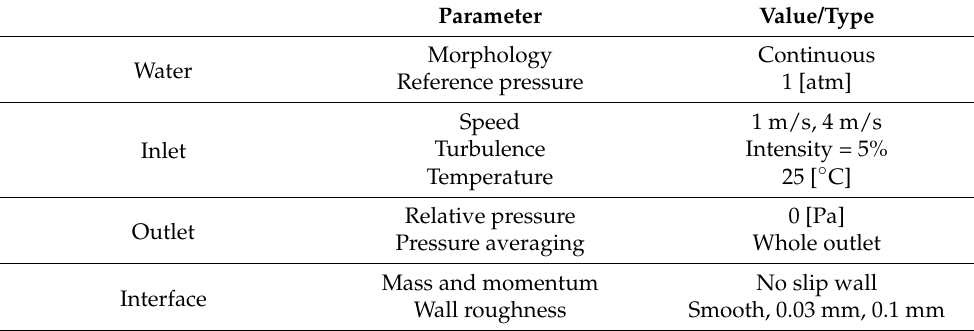
Table 4. Summary of boundary conditions of the fluid